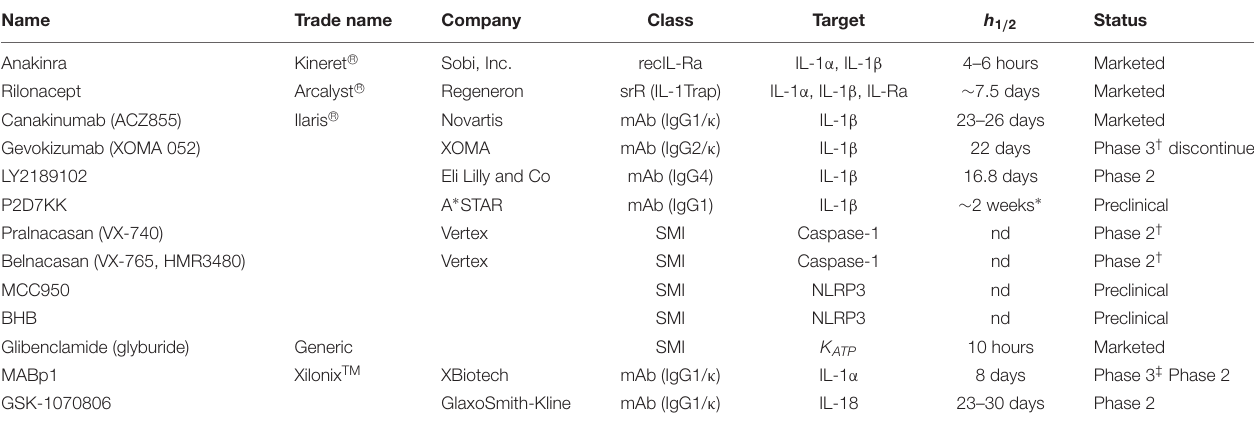
TABLE 1 | Biologics and inhibitors of IL-1, IL-18, and inflammasome